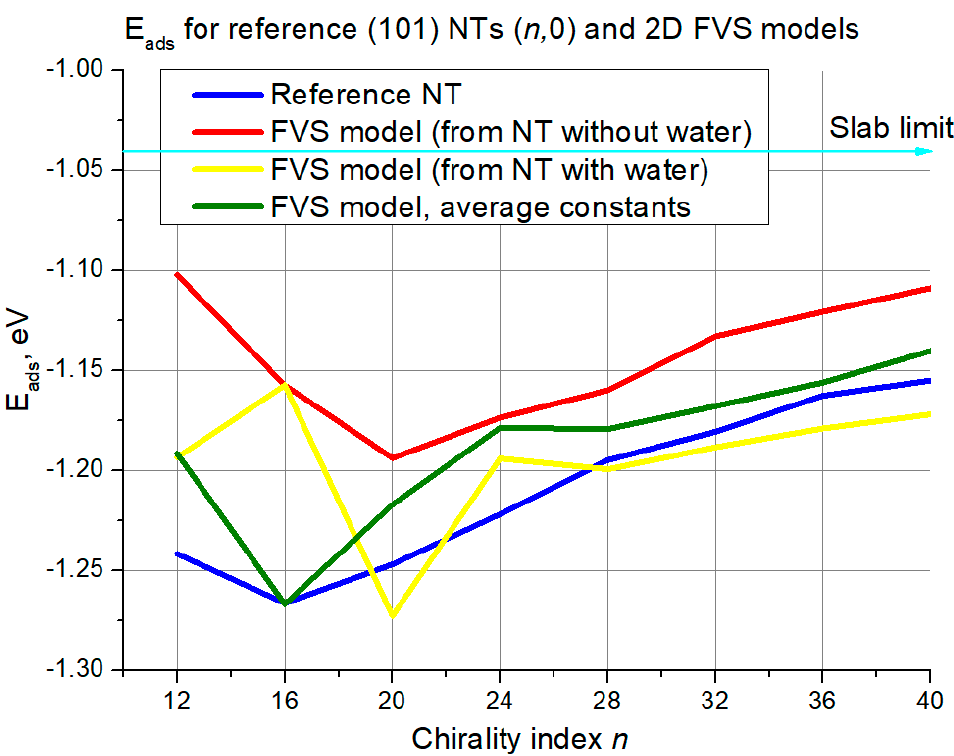
Figure 6. Adsorption energies for (101) NTs ( n ,0) and their 2D FVS models. The cyan line with an arrow denotes the slab limit for water adsorption